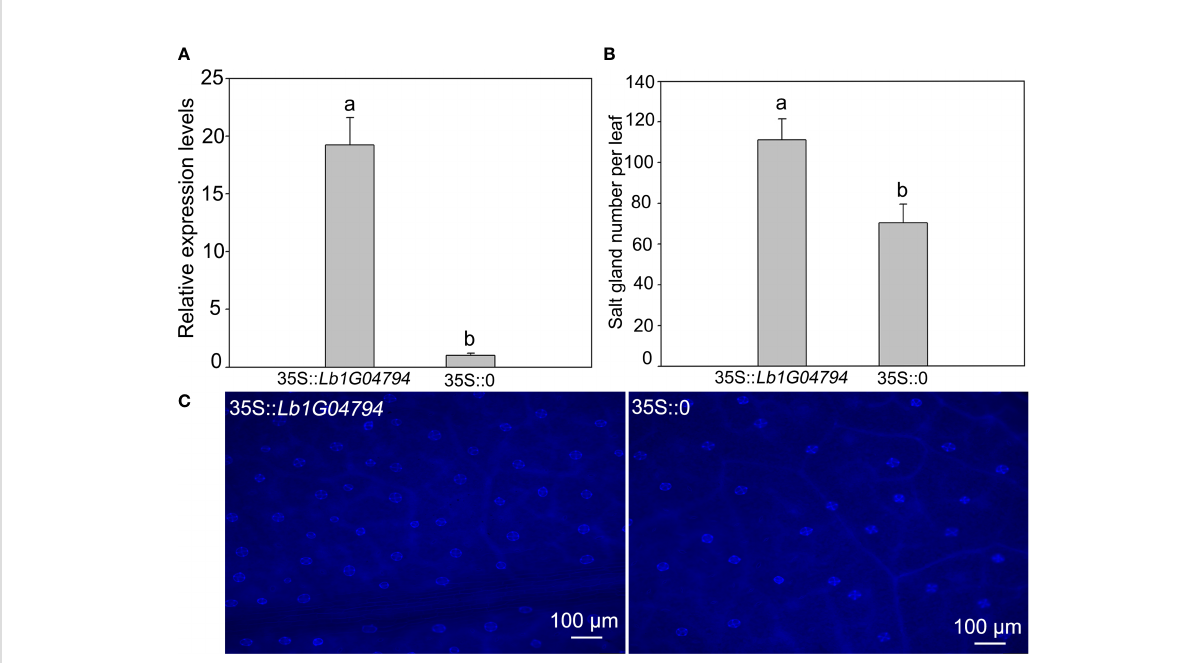
FIGURE 2 The salt gland phenotypes and quanti fi cation after overexpressing Lb1G04794 in L. bicolor . (A) The expression level of overexpression line (35S:: Lb1G04794 ) and control (35S::0). (B) The total number of salt glands per leaf. Data are means ± SD of three seedlings; different letters indicate signi fi cant differences at P = 0.05 according to Duncan ’ s multiple range test. (C) The salt gland phenotypes in overexpression line and control under 330 – 380 nm